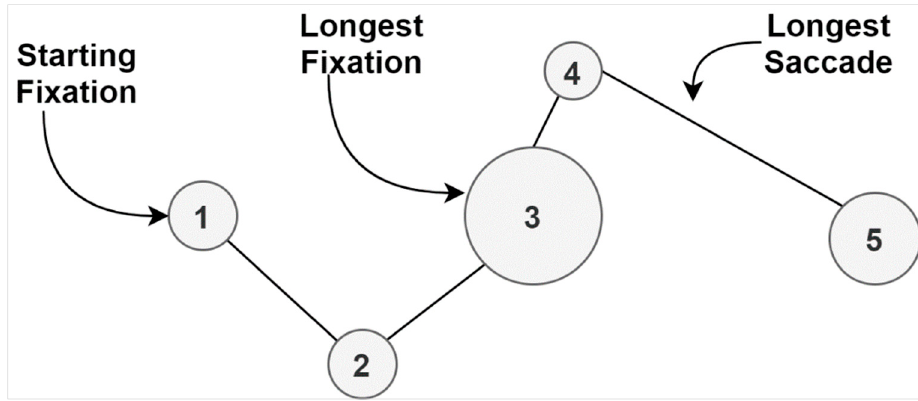
Figure 3. Eye-tracking scanpath [56].